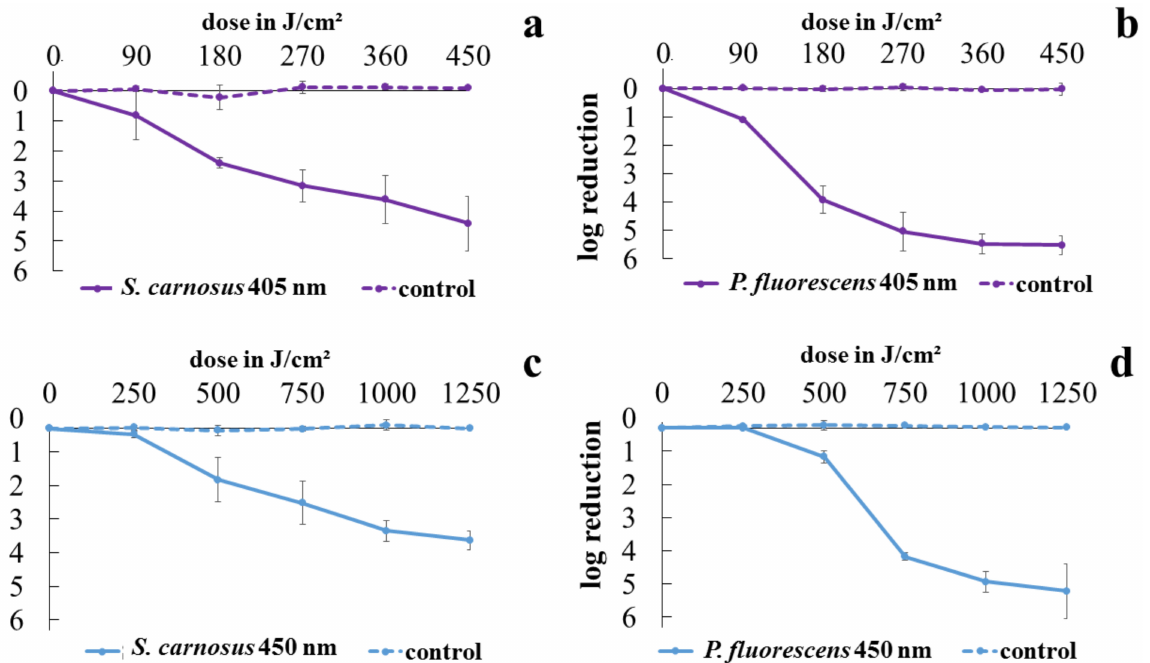
Figure 1. Inactivation progress of S. carnosus irradiated with 405 nm ( a ) and 450 nm ( c ) as well as inactivation progress of P. fluorescens at 405 nm ( b ) and 450 nm ( d ). Error bars are representing the standard deviation of three independent